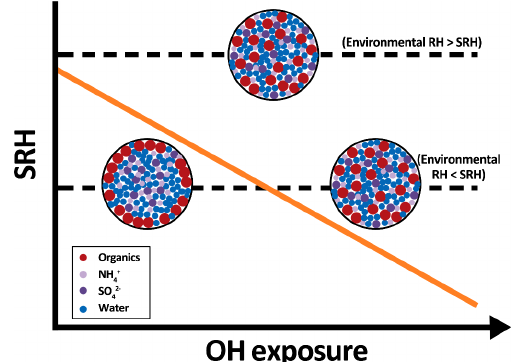
Figure 4. A simplified diagram illustrating the change in separation relative humidity (SRH, orange solid line) and phase composition of droplets containing inorganic salts and organic compounds (single liquid phase vs. liquid–liquid phase separated) upon heterogeneous oxidation at two different environmental